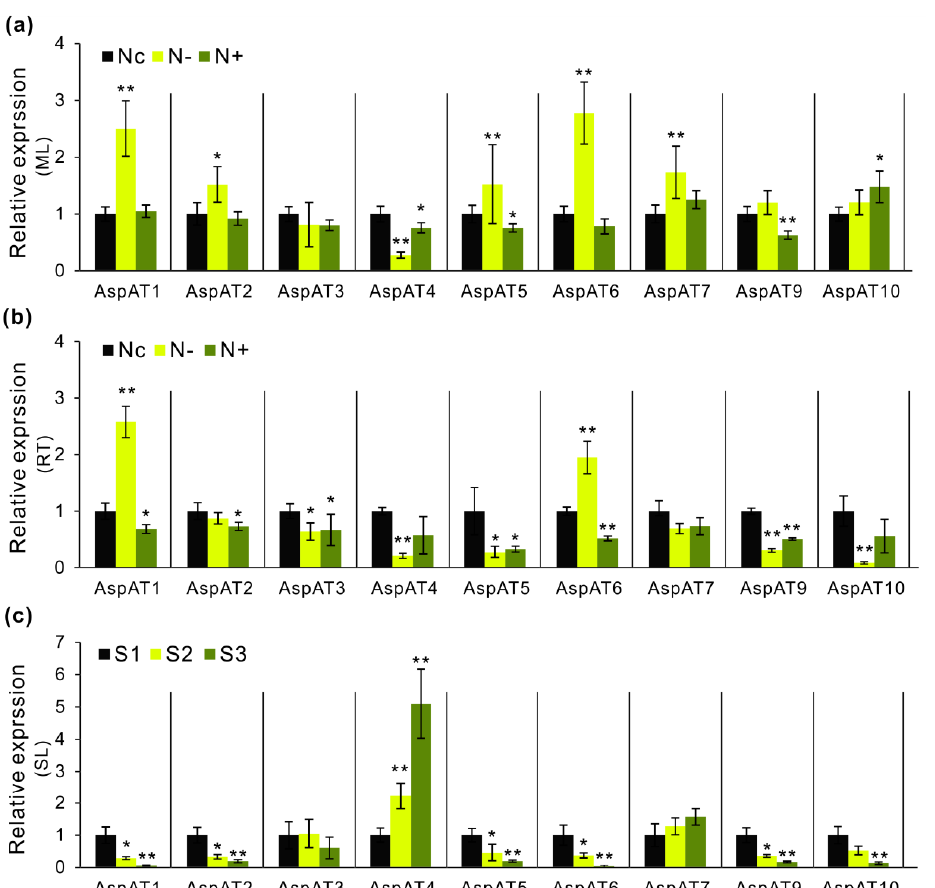
Figure 7. Transcript analyses of AspATs in response to the perturbation of N nutrients and seasonal senescence. ( a , b ) qRT-PCR analyses showing the e ff ects of AspATs expression upon the altered N nutrient (NH 4 NO 3 ), N– (0 mM), Nc (2 mM), and N + (10 mM). Respective samples were harvested in poplar ‘ Nanlin895 ’ after four weeks of N treatments. ( c ) qRT-PCR analyses showing the e ff ects of AspATs expression at three stages of senescent leaves (SL) in the poplar ‘ Nanlin895 ’. Relative expression of the control (Nc or S1) was set as 1. Data represent mean values ± SE of at least three independent biological replicates for qRT-PCR. PtActin , PtUBIC , and PtEF1 α were used as reference genes. Asterisks indicate significant di ff erences in comparison with the control using the Student’s t -test: *** p < 0.001, * p < 0.05 .